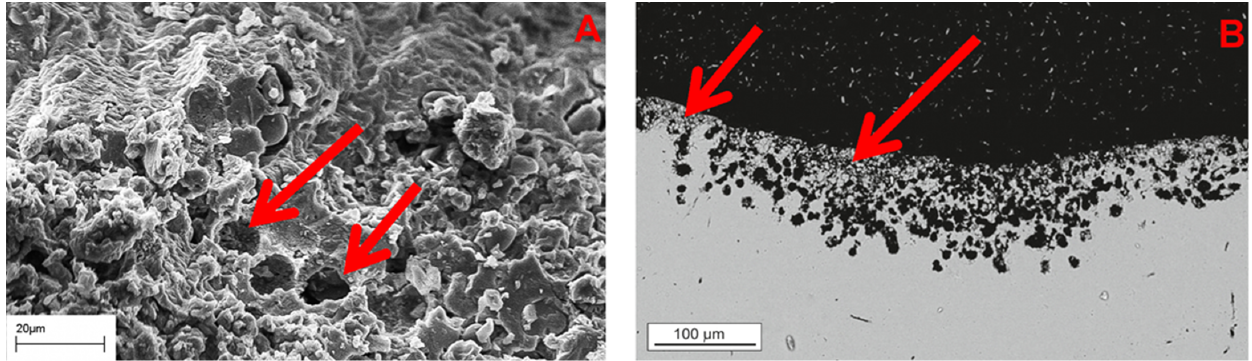
Figure 18. The in fl uence of microorganisms on the weathering of limestone detected by SEM— clusters of yeast-like cells, site 2 ( A ), microcolonies of yeast-like cells, site 4 ( B ), microcolonies embedded in deep caverns, site 4 ( C – D ), samples from site 5 observed under Keyence Digital Microscope ( E , F ).